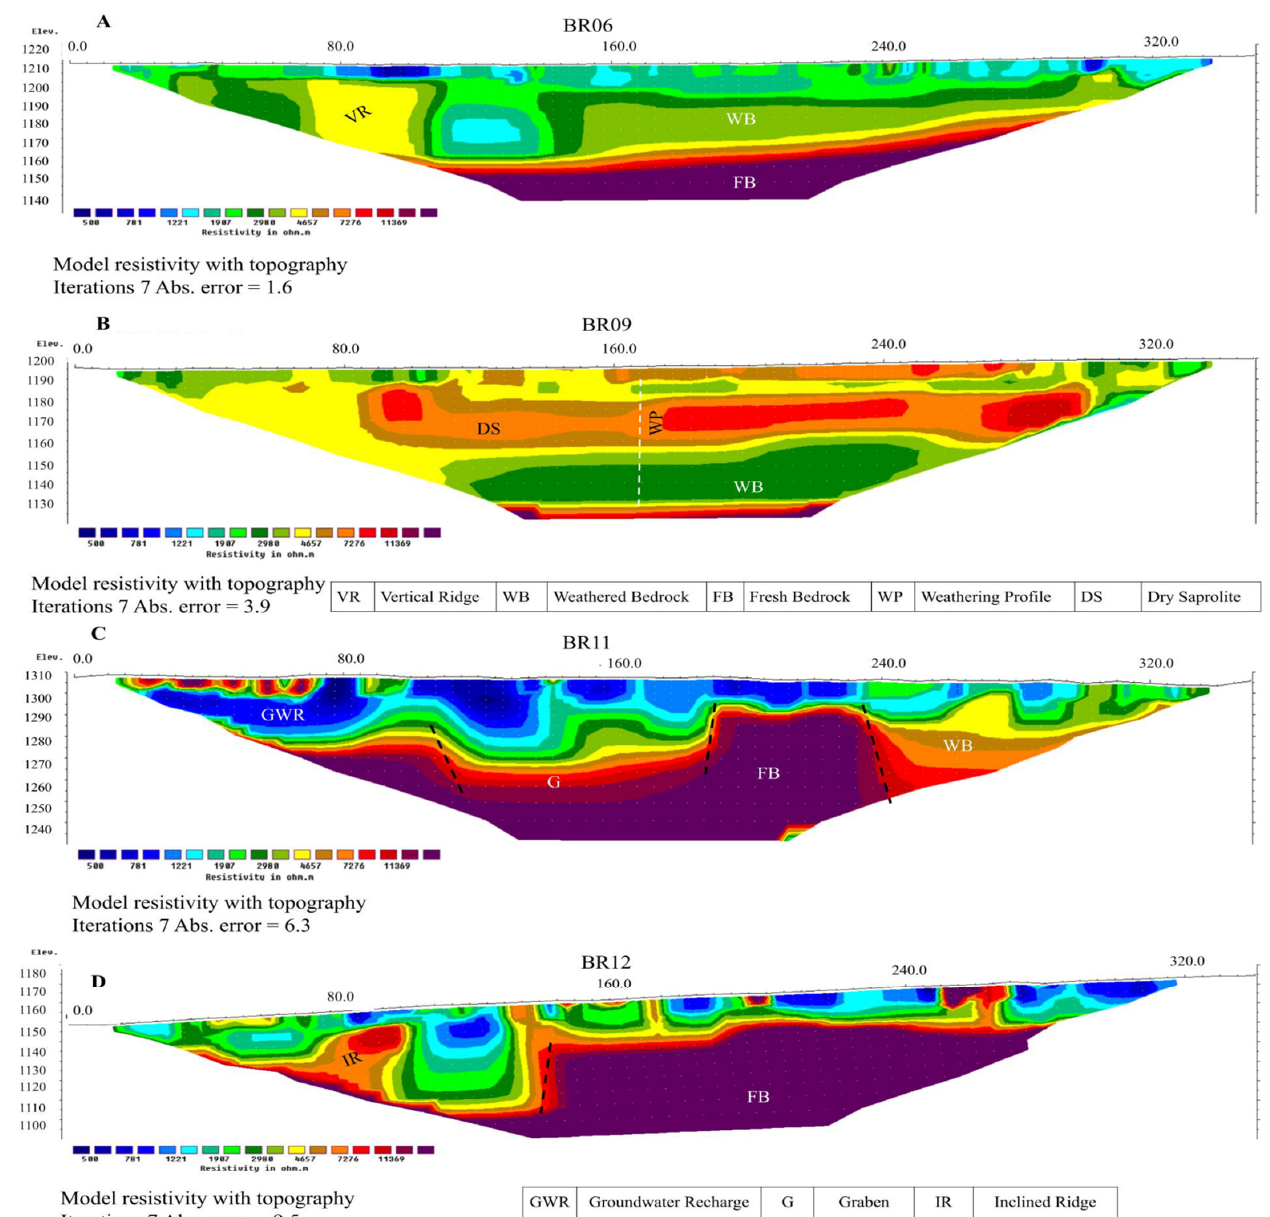
Figure 8. 2D resistivity models ( A – D ) in the region of Brasilia using the dipole-dipole array. Fault mapping is key to understanding groundwater flow in hard-rock aquifers